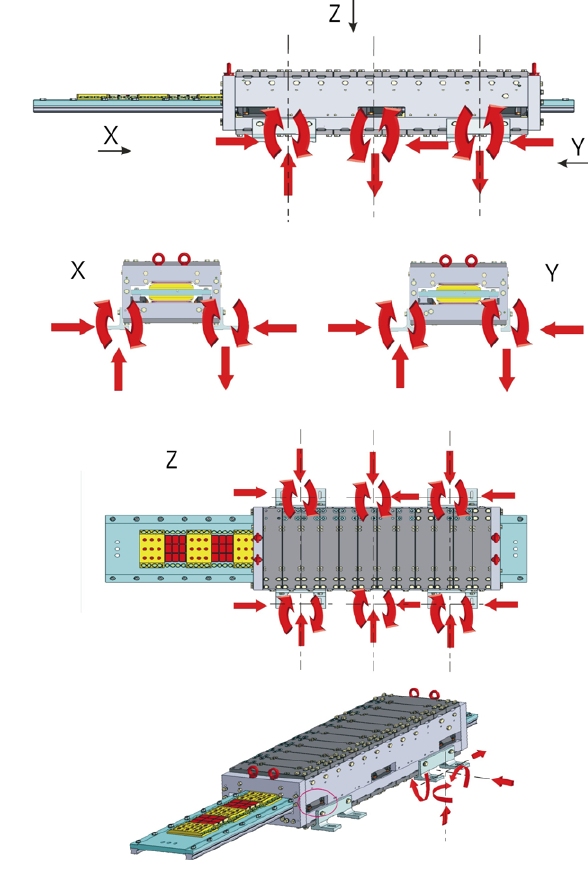
Figure 34: Forces and moments imposed to the actuator frame to the joint brackets.